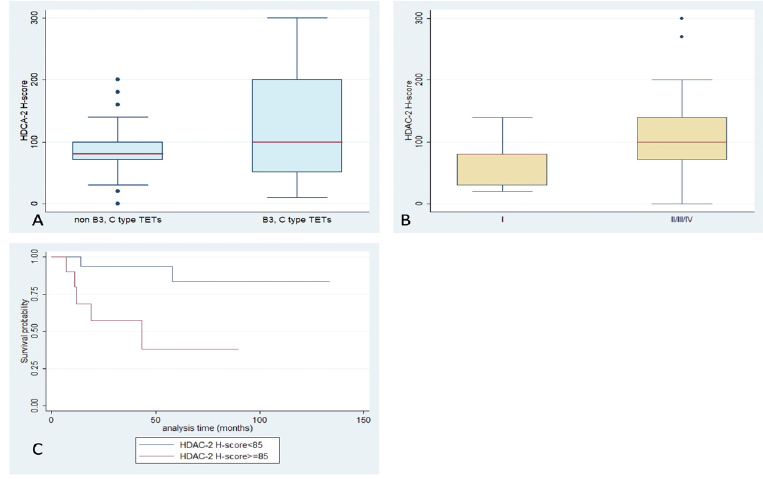
Figure 3. Schematic representation of the associations between HDAC2 H-score and ( A ) WHO his- tological type, ( B ) Masaoka–Koga stage, and ( C ) patients’ overall survival.